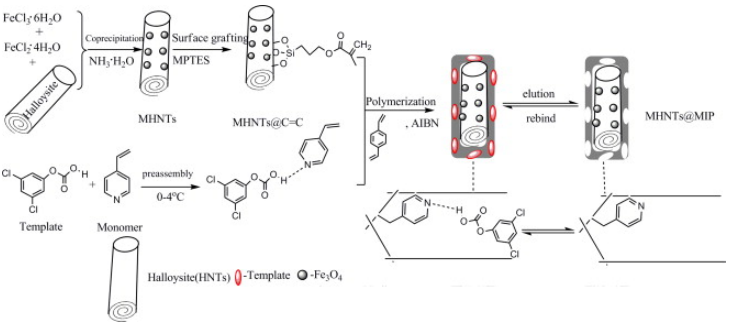
Figure 18. Schematic representation of preparing MHNTs@MIP. Reproduced with permission from [150].